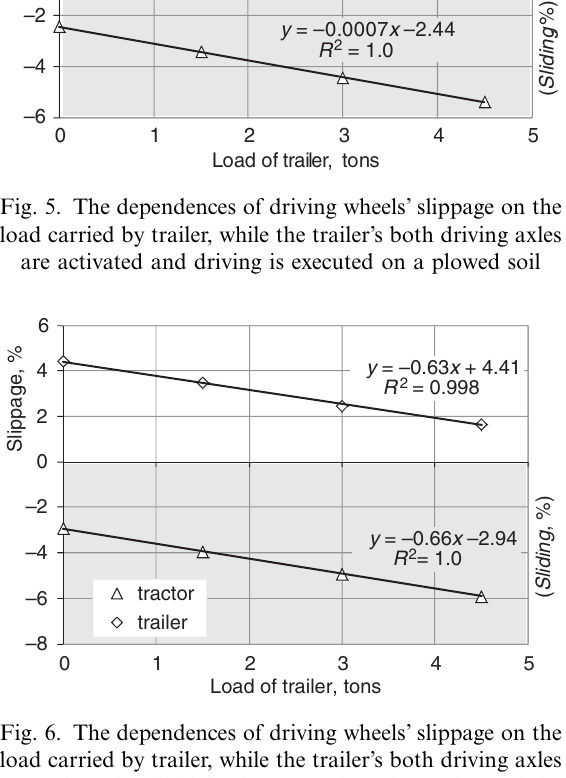
Fig. 6. The dependences of driving wheels’ slippage on the load carried by trailer, while the trailer’s both driving axles are activated and driving is executed on the tracks made by previous driving